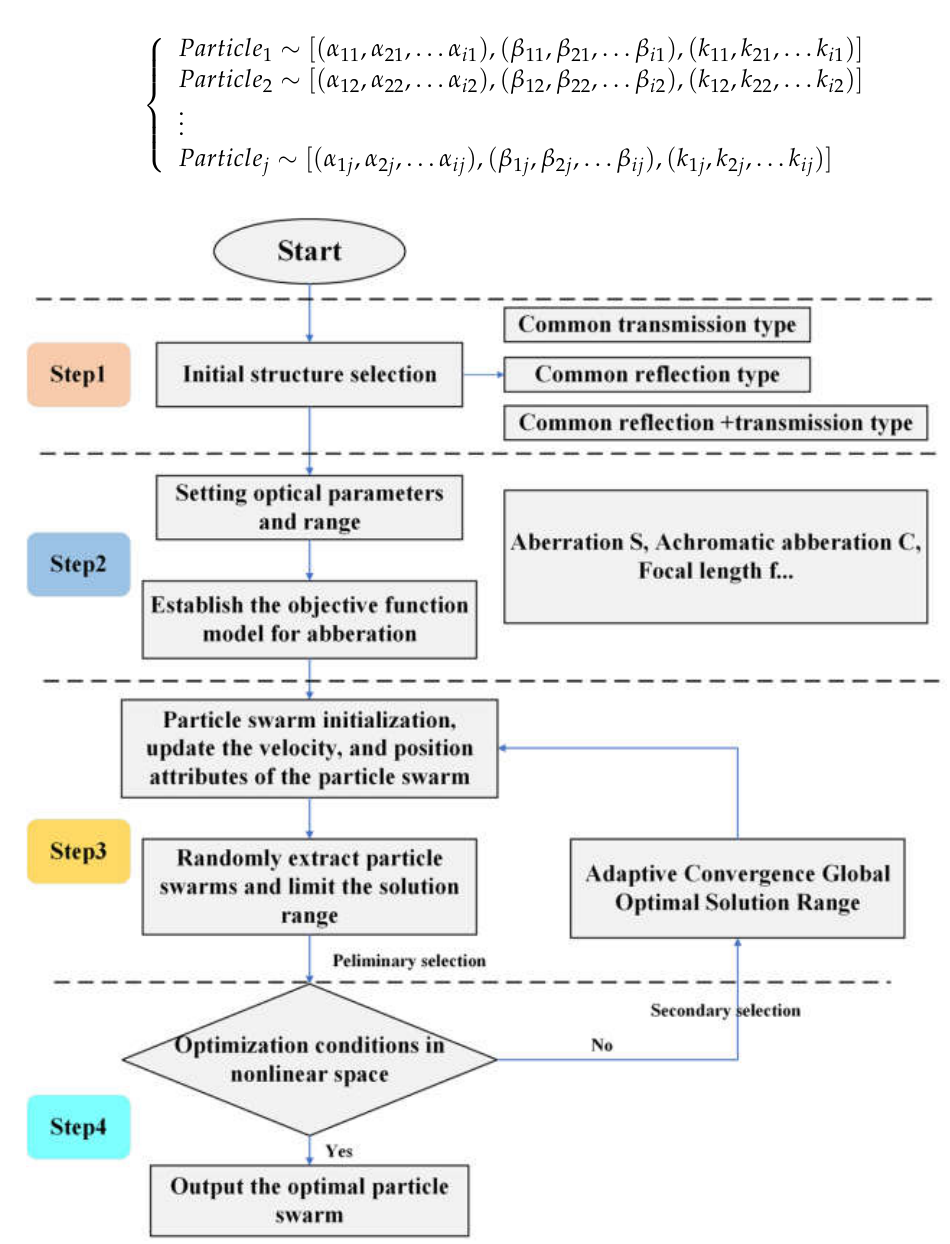
Figure 1. Multi-level screening model based on adaptive particle swarm optimization.